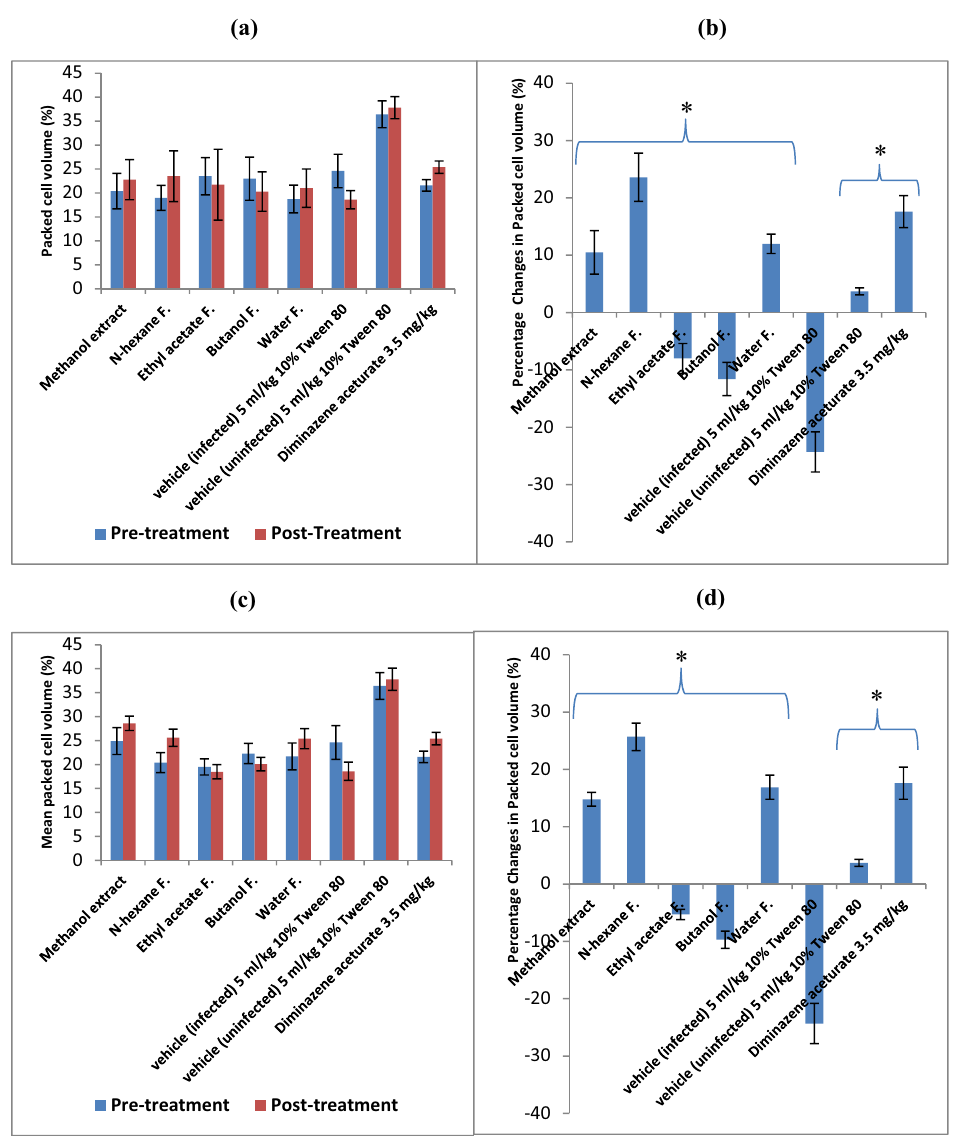
Figure 4: E ff ect of extract and fraction on PCV of T. brucei brucei - infected animals. ( a ) 200 mg/kg extract and fraction e ff ect on PCV; ( b ) 200 mg/kg extract and fraction e ff ect on percentage changes in PCV; ( c ) 400 mg/kg extract and fraction e ff ect on PCV; and ( d ) 400 mg/kg extract and fraction e ff ect on percentage changes in PCV. * P < 0.05 compared to the vehicle - treated control